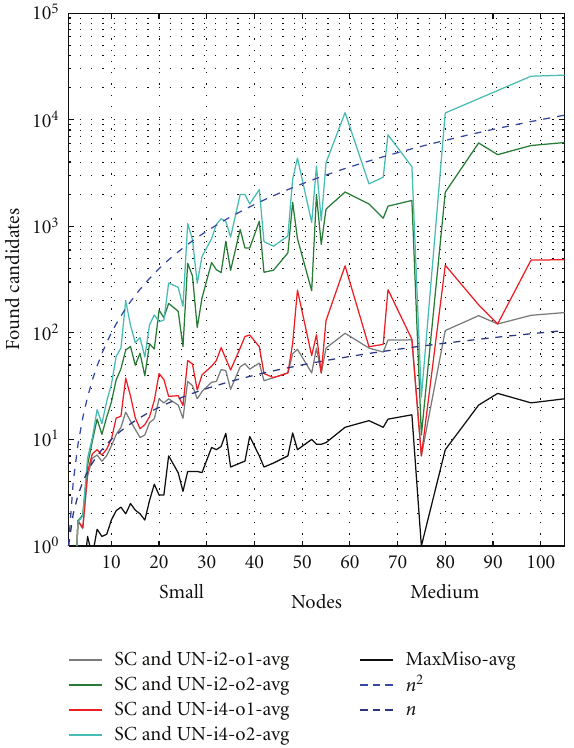
Figure 6: Number of found candidates by ISE algorithms for a me- dium spectrum of BB nodes, where SC and UN have variable con-